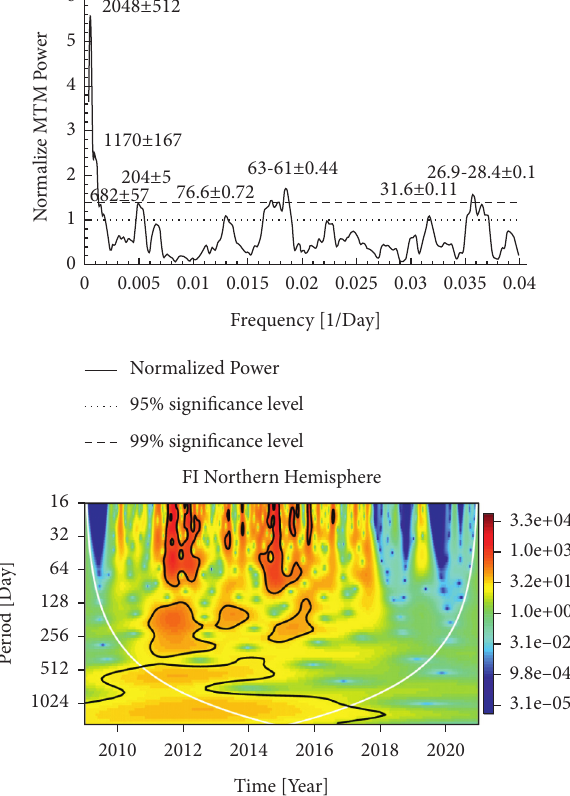
Figure 2: MTM (upper panel) and Morlet wavelet (lower panel) analysis results for Northern Hemisphere FI data for the investi- gated time interval. White solid line in the wavelet scalogram shows the cone of influence (COI); black solid lines show the significant periodicities. horizontal dashed and long dashed lines represent 95% and 98% confidence levels. All peaks exceeding the dashed line show the meaningful periods with at least 95% confidence